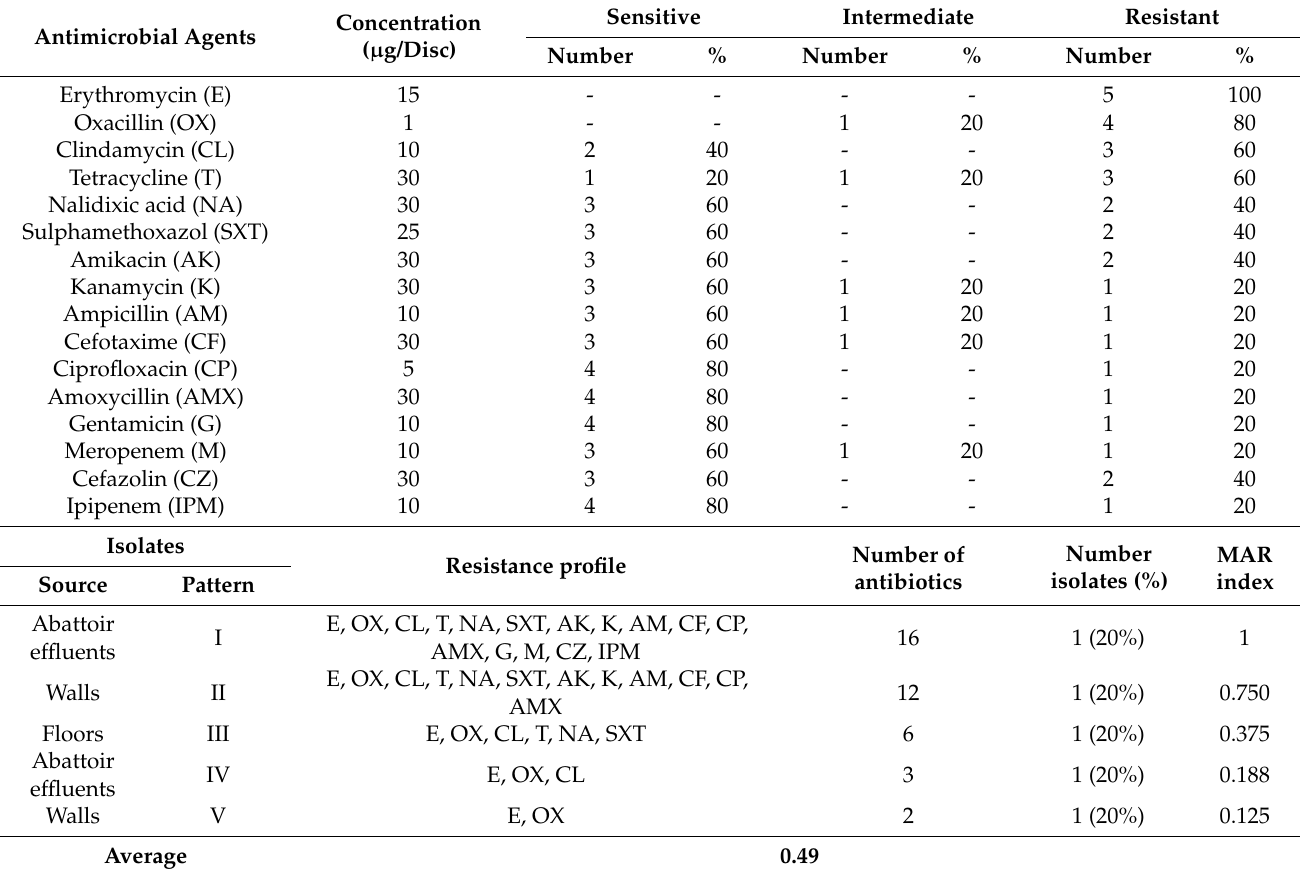
Table 2. Antimicrobial susceptibility and resistance profile of S. typhimurium